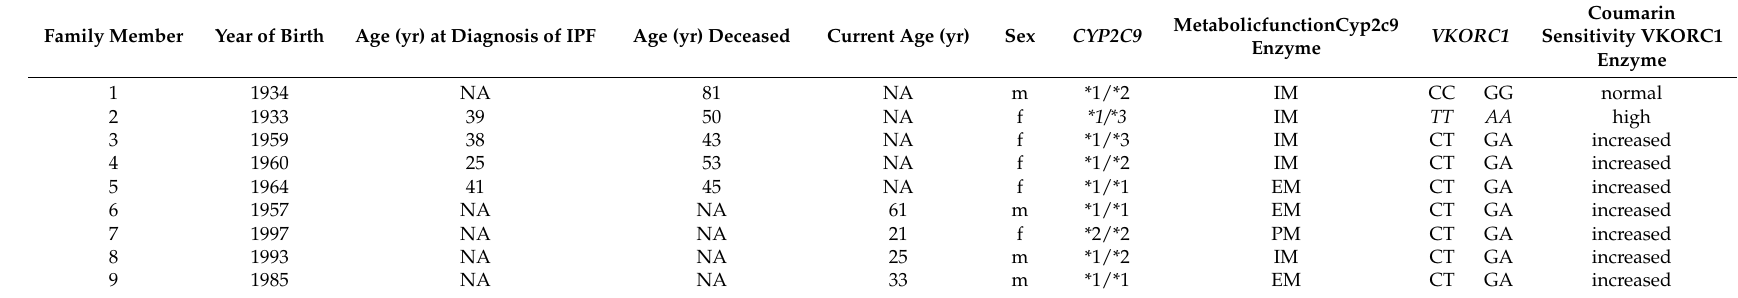
Table 1. Characteristics of the studied